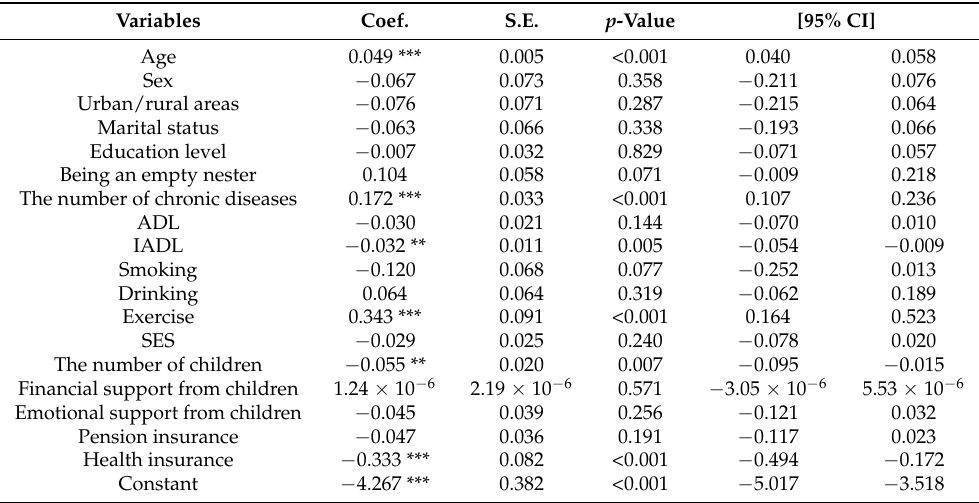
Table 2. Estimates of the use of home and community care services.